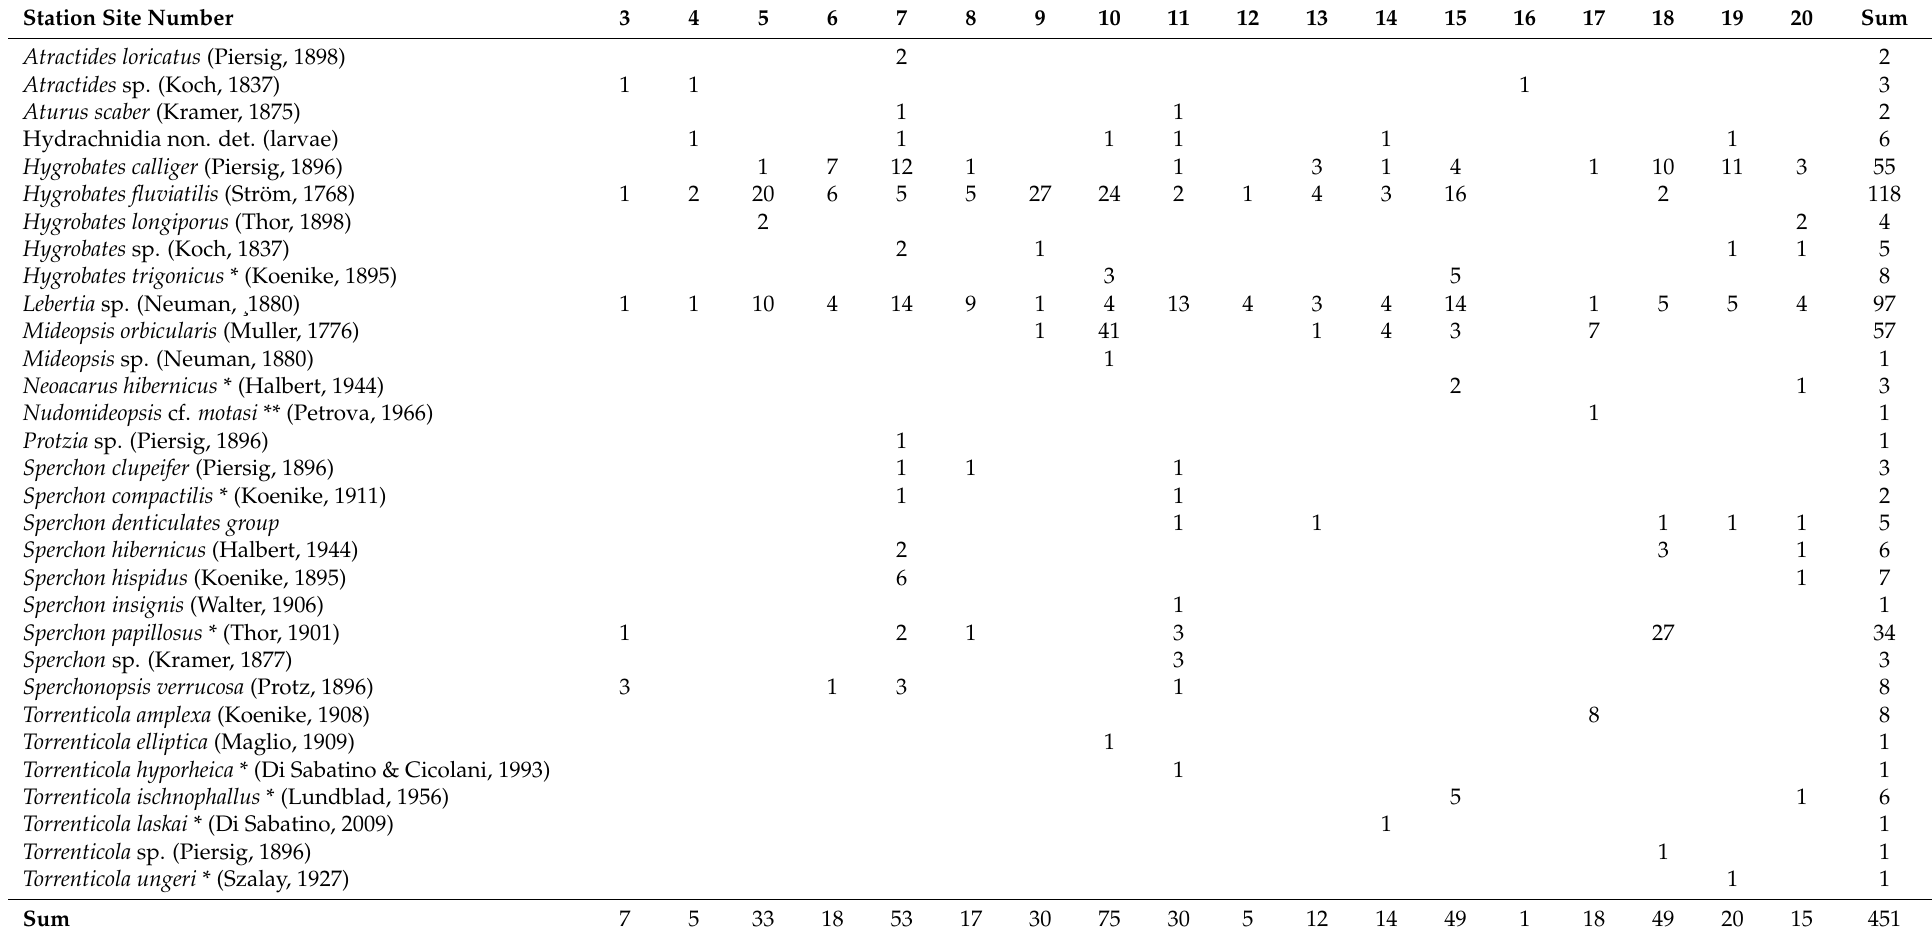
Table 1. Water mite specimens collected from 20 sites of the Bednja lowland river. No water mites were found in the samples collected on sites 1 and 2. Station Site